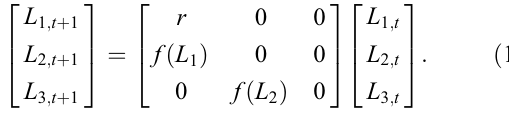
maximisation algorithm. Different numbers of size classes were fi tted using the normalmixEM function in R (Benaglia